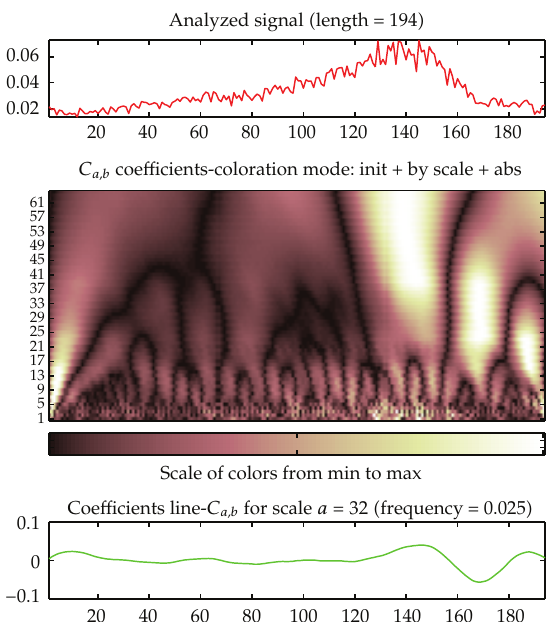
Figure 7: Comparison of data with theoretical assumptions.